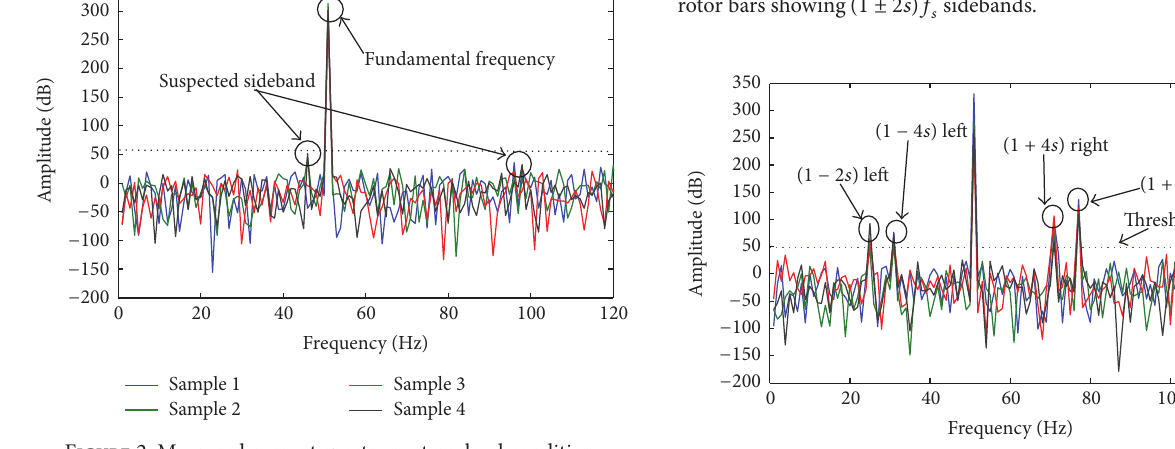
Figure 2: Measured current spectrum at no-load condition.